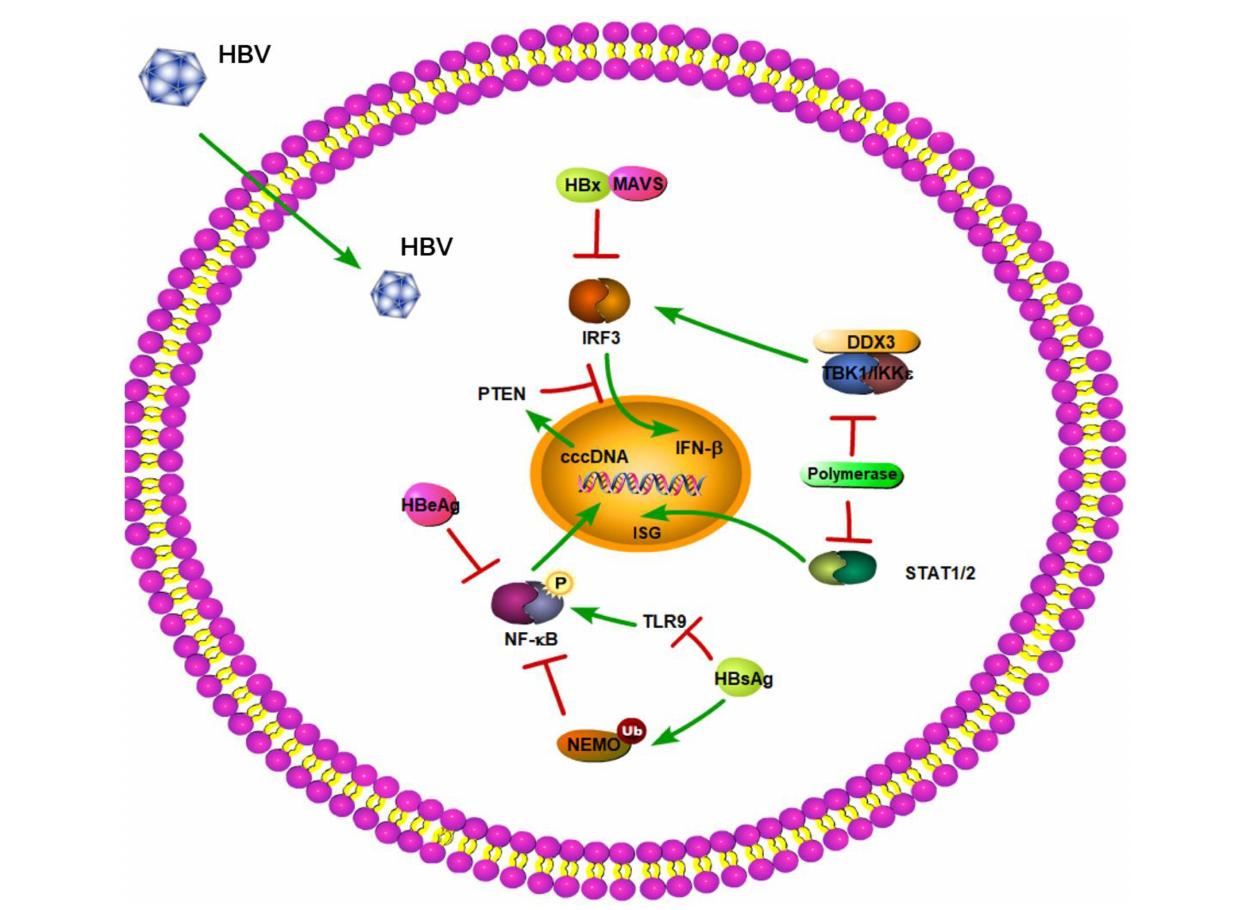
FIGURE 2 | Hepatitis B virus suppression of type I interferon (IFN) response (green arrows indicate the related signaling pathways and T-arrows in red indicate blocking the targets). HBsAg inhibits TLR9 and mediates the ubiquitination of NEMO to suppress the NF-kB pathway. HBeAg can inhibit phosphorylation of NF-kB. HBV polymerase can block the nuclear translocation of activator of transcription 1 (STAT1). HBV polymerase is able to disrupt the interaction between TBK1/IKK ε and DEAD box protein 3 (DDX3) to play a novel role in HBV counteraction of IFN- β production. HBx interacts with MAVS to act as a suppressor of virus-triggered induction of type I IFNs. HBV infection can also reduce PTEN protein expression to inhibit IFN signaling pathway.